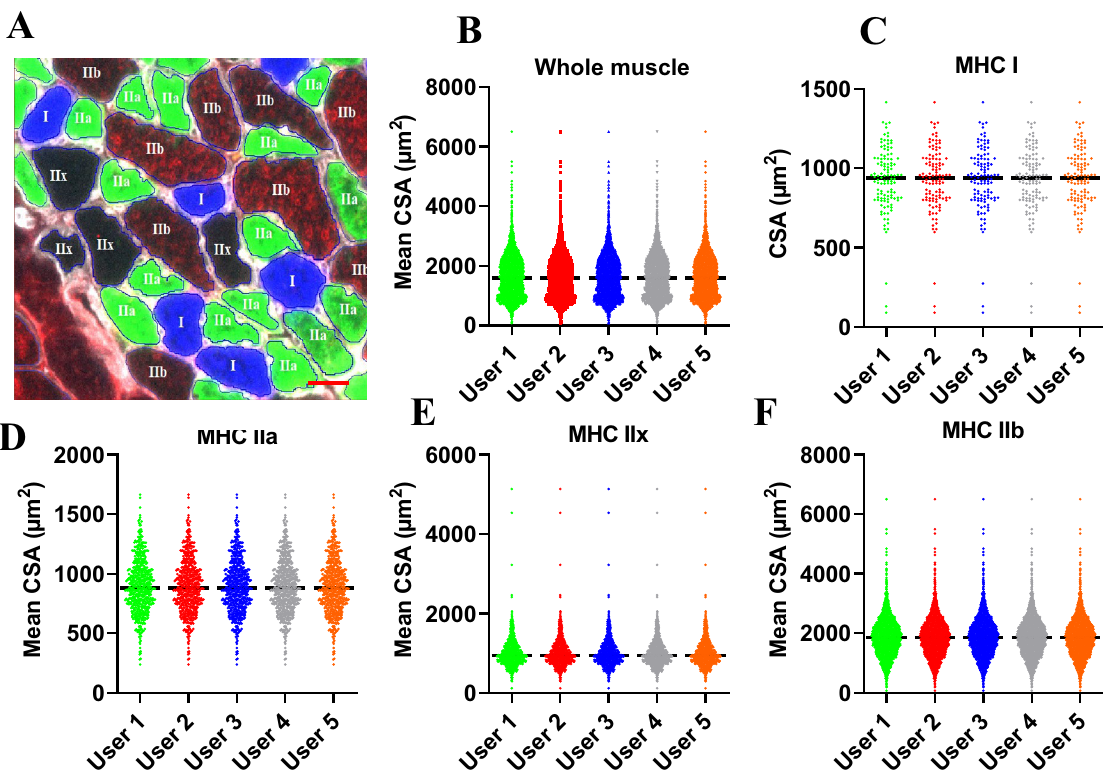
Figure 6. Inter-user reliability. Independent analyses of mean CSA as a function of fiber type by 5 users. Data from whole gastrocnemius muscle images obtained from 16- to 18-week-old C57BL/6 mice on 56 days (D56) post-HIIT program. ( A ) Representative image measured by MyoView for measuring different fiber types. ( B ) Mean CSA of whole muscle fibers. ( C ) Mean CSA of MyHC I fibers. ( D ) Mean CSA of MyHC IIa fibers. ( E ) Mean CSA of MyHC IIx fibers. ( F ) Mean CSA of MyHC IIb fibers. Bar = 25